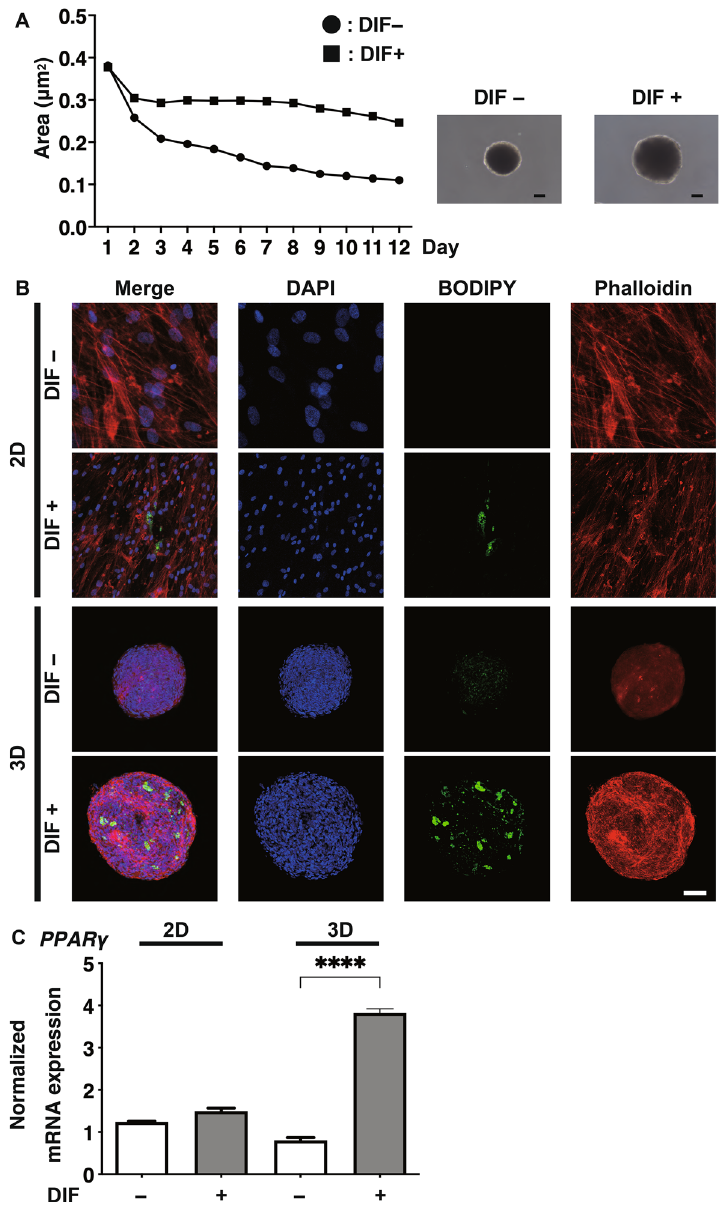
Figure 1. Changes in the sizes of three-dimension (3D) organoids of human orbital fibroblasts (HOFs) during the 3D cell culture, confocal immunostaining images by lipid staining (BODIPY), phalloidin, and DAPI of two- dimension (2D) and 3D cultured HOFs, and mRNA expressions of peroxisome proliferator-activated receptor γ (PPARγ) of 2D or 3D cultured HOFs. (Panel A ) Mean sizes of the 3D organoids of HOFs preadipocytes (DIF−, closed circles) and for adipogenic differentiation (DIF+ , closed squares) were plotted during the 12 days period of the 3D culture, and representative phase contrast images are shown. Scale bar: 100 µm. (Panel B ): At Day 12, 2D cultured HOFs (DIF− or DIF+) or 3D HOFs organoids (DIF− or DIF+) were immunostained with BODIPY (green), Phalloidin (red) and DAPI (blue). Scale bar: 100 µm. (Panel C ): mRNA expressions of PPARγ of 2D or 3D cultured HOFs (DIF− or DIF+) were plotted. All experiments were performed in duplicate using fresh preparations consisting of 5 organoids each. Data are presented as the arithmetic mean ± the standard error of the mean (SEM). **** P < 0.001 (ANOVA followed by a Tukey’s multiple comparison